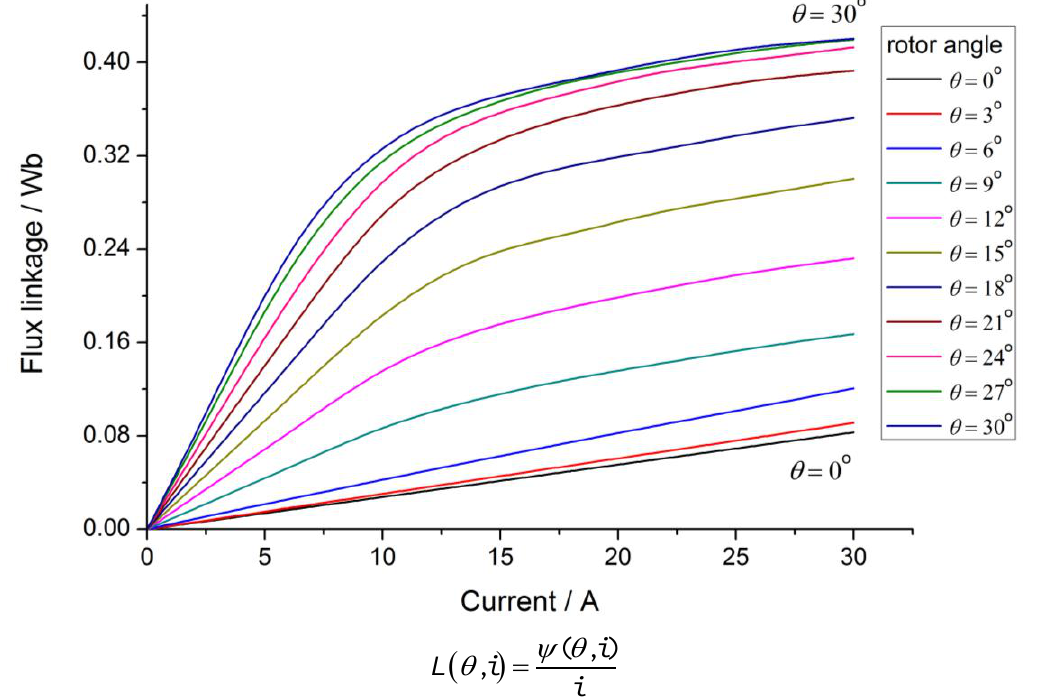
Figure 10. Magnetizing characteristic ( Ψ-i ) curves of one